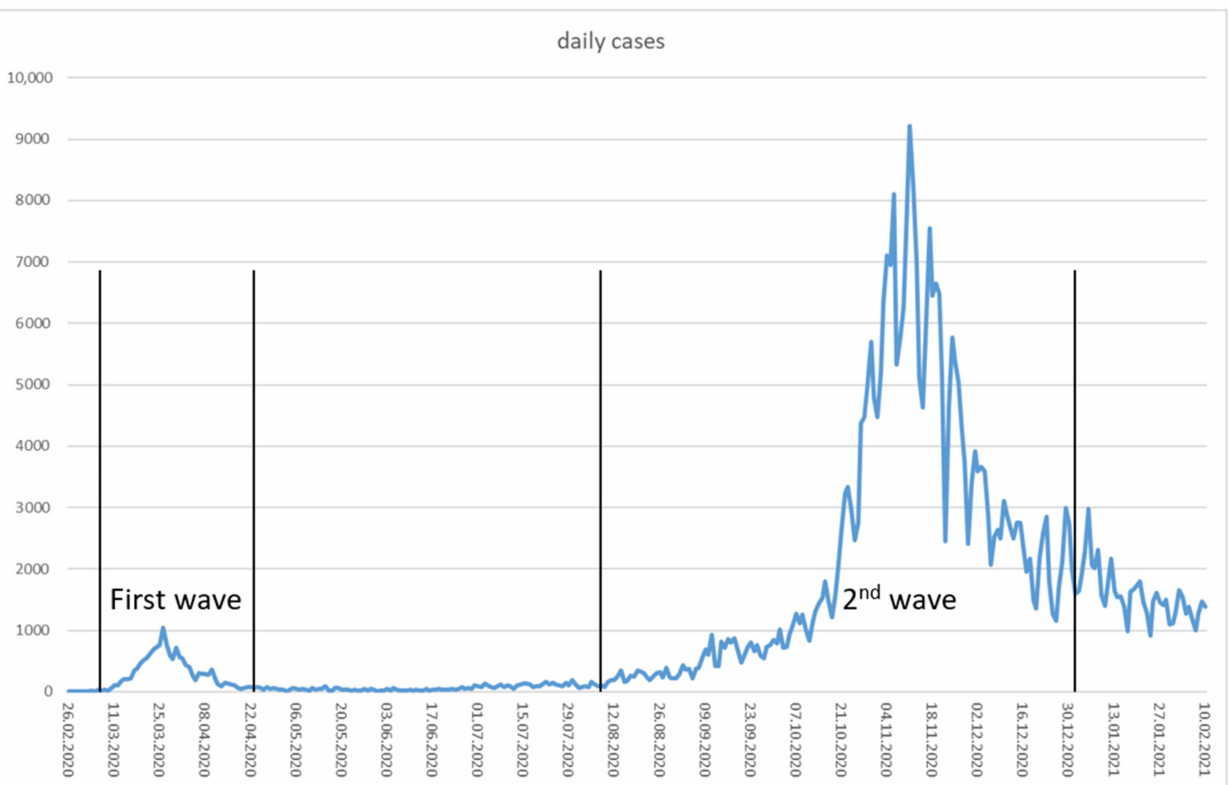
Figure 1. Time course of daily COVID-19 diagnoses in